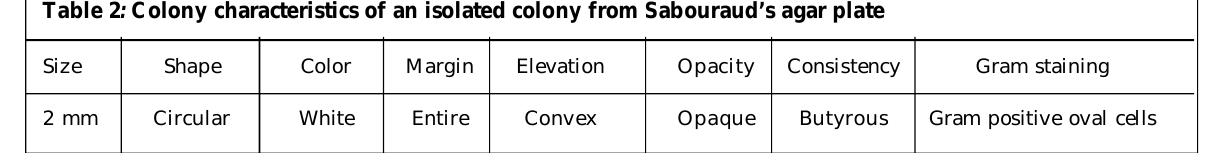
Figure 2: Idli batter after fermentation at ambient temperature (30 °C) for 6 h